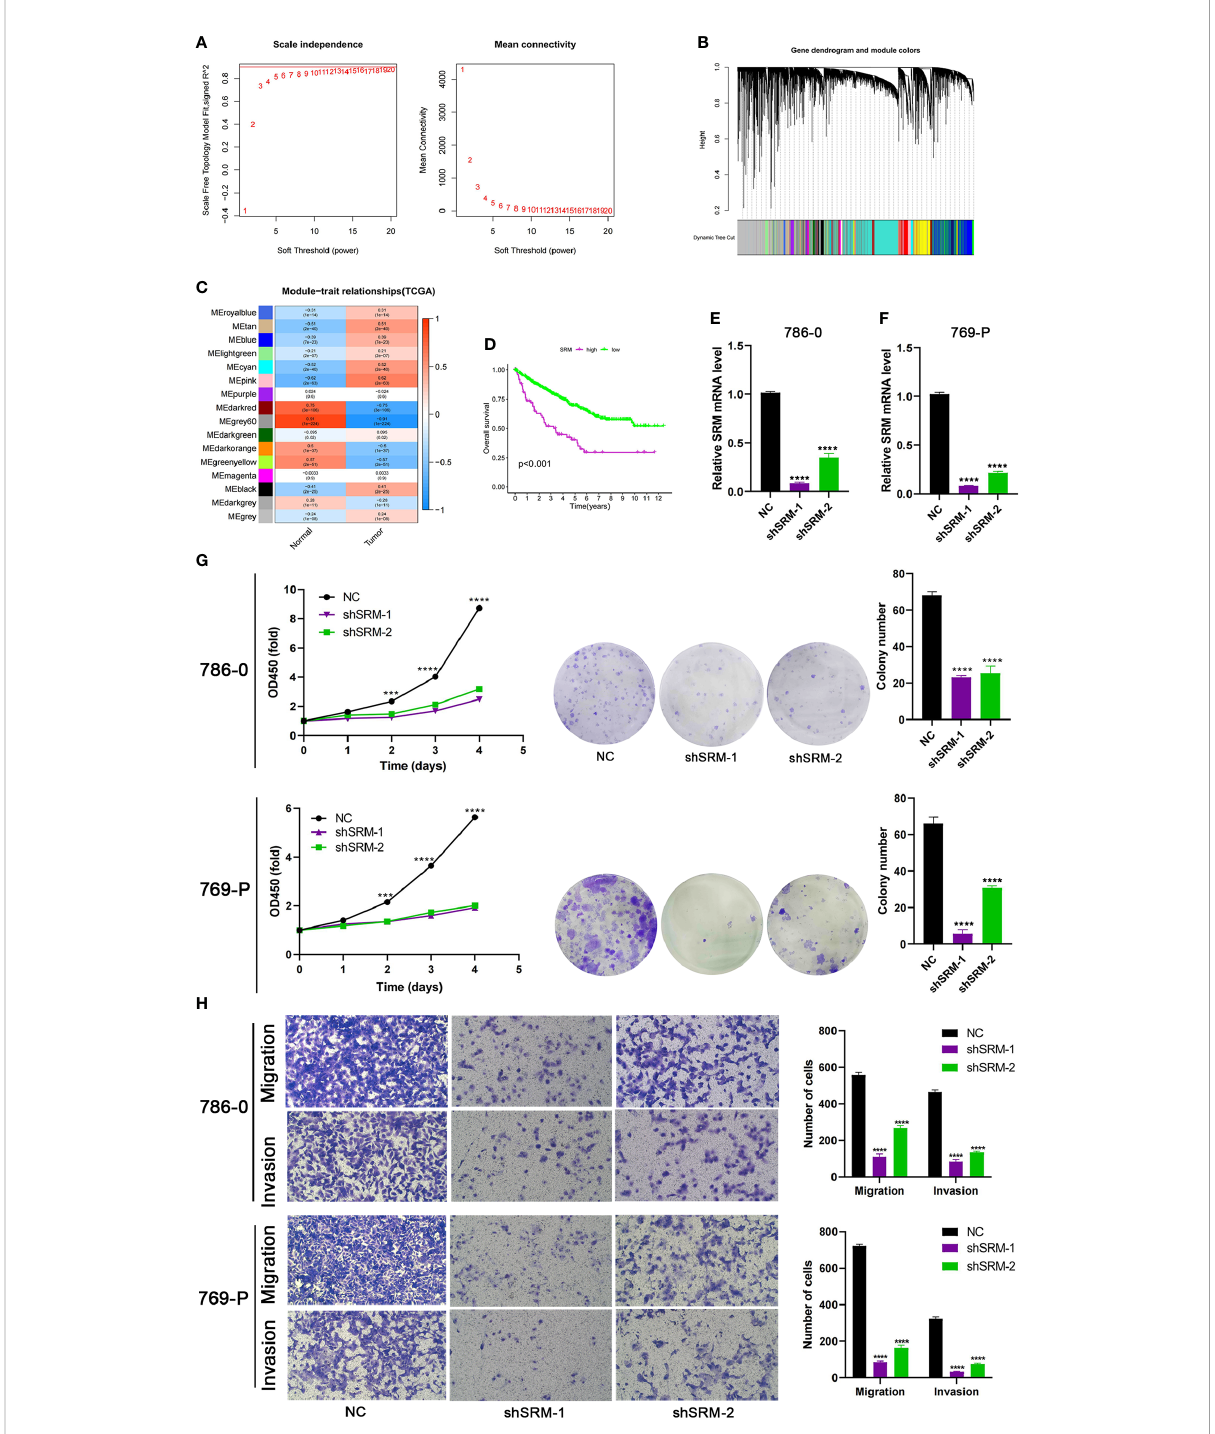
FIGURE 9 Identi fi cation of key PMRGs in ccRCC and in vitro cell function experiments. (A) Screening of soft threshold. (B) Hierarchical clustering dendrogram of 16 modules. (C) Heatmap of correlations between modules and tumor. (D) K – M curves of SRM in protein levels. (E – F) Knockdown ef fi ciency of SRM in 786-0 and 769-P. (G) Effects of SRM knockdown on CCK8 and clone formation ability of ccRCC cells. (H) Transwell was used to detect the effect of SRM on the migration and invasion ability of 786-0 and 769-P. PMRGs, polyamine metabolism-related genes; ccRCC, clear cell renal cell carcinoma. ***p < 0.001, ****p <